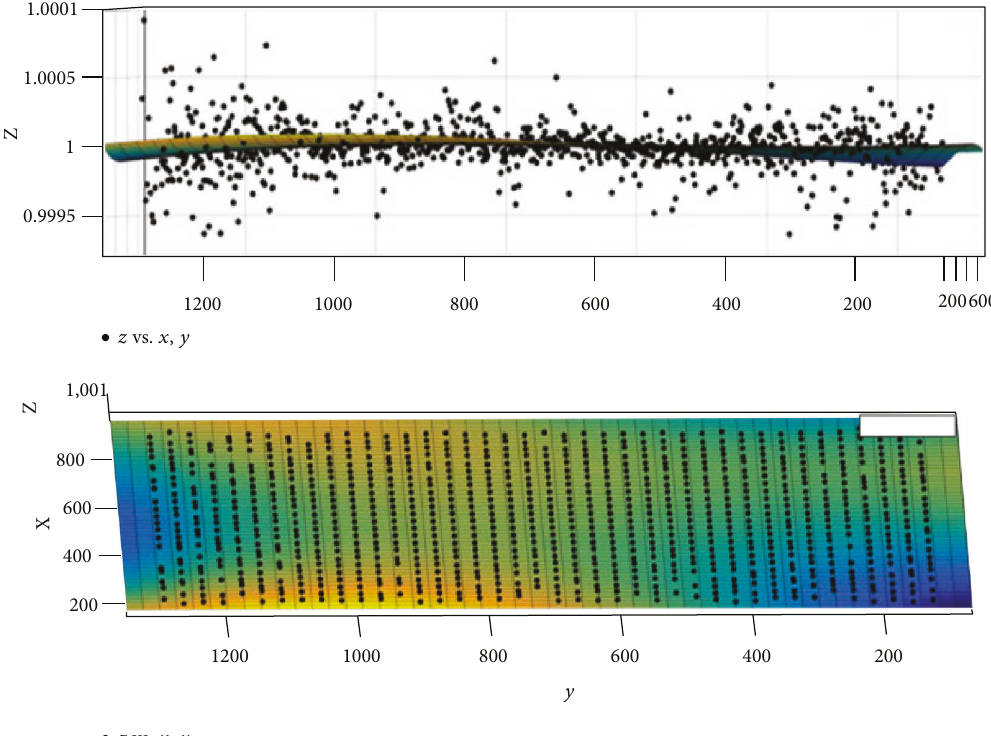
Figure 19: The minimum LAR surface optimization algorithm on the setting, running on two images taken continuously with no movement. The upper part of the fi gure shows the surface from the ZY plane viewpoint, and the lower part shows the XY plane viewpoint.